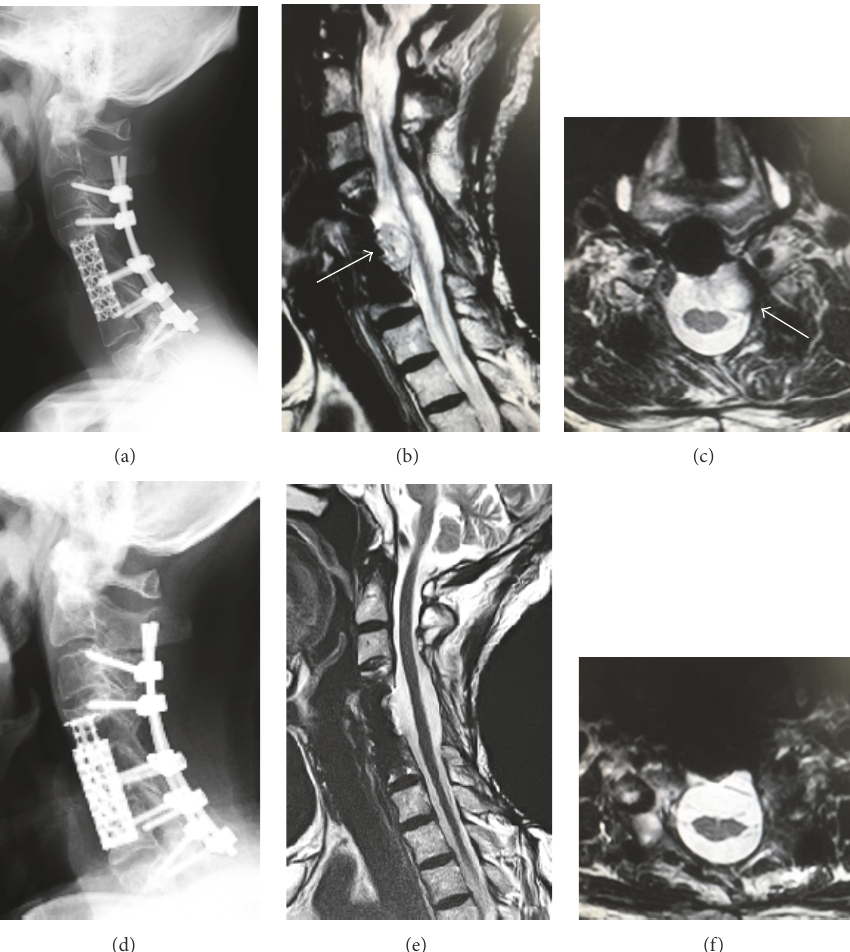
Figure 2: Roentgenogram after surgery. (a) Lateral radiograph showing posterior cervical interbody fusion with the artificial vertebral body of C3 to T1 after the first surgery. (b, c) Sagittal (b) and axial MRI scan (c) at 6 years after the initial surgery with a third recurrence of the tumor. (d) Lateral radiograph of the cervical spine, and sagittal (e) and axial views (f) of the MRI image, showing no recurrence at 8 years 4 months after the first